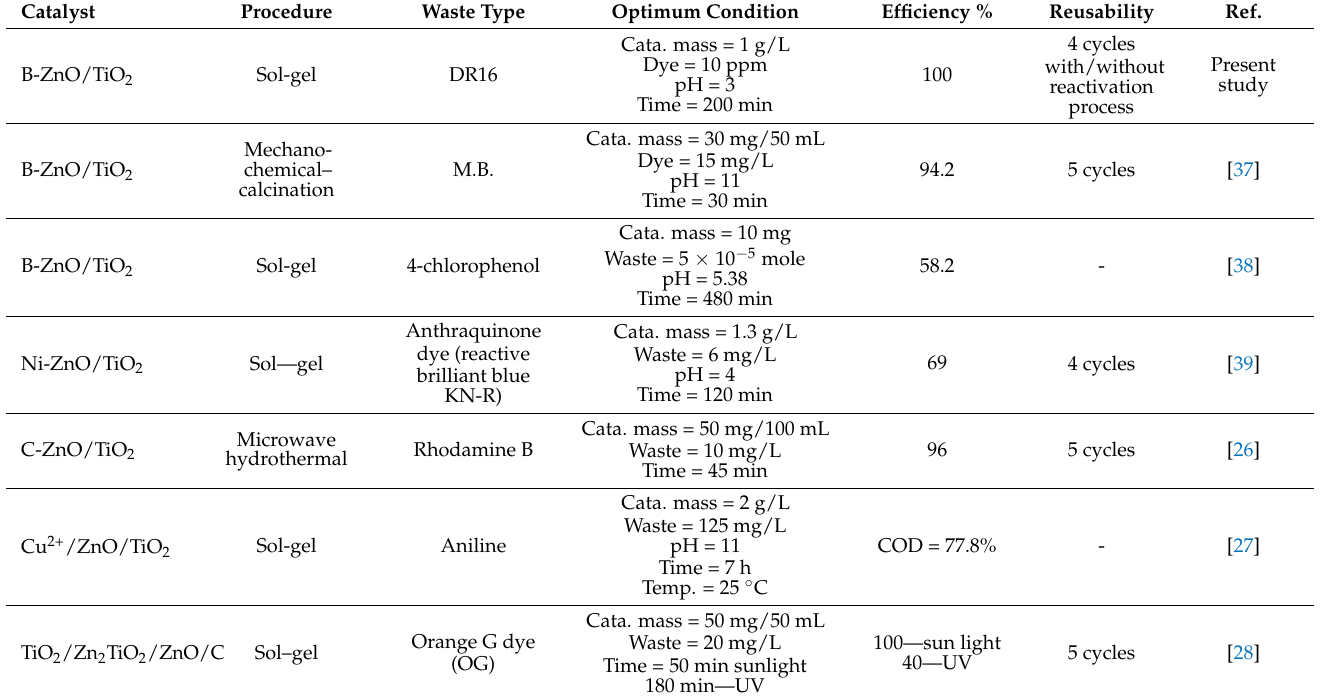
Table 7. Performance comparison of some published works focusing on the fabrication of ZnO/TiO 2 - based